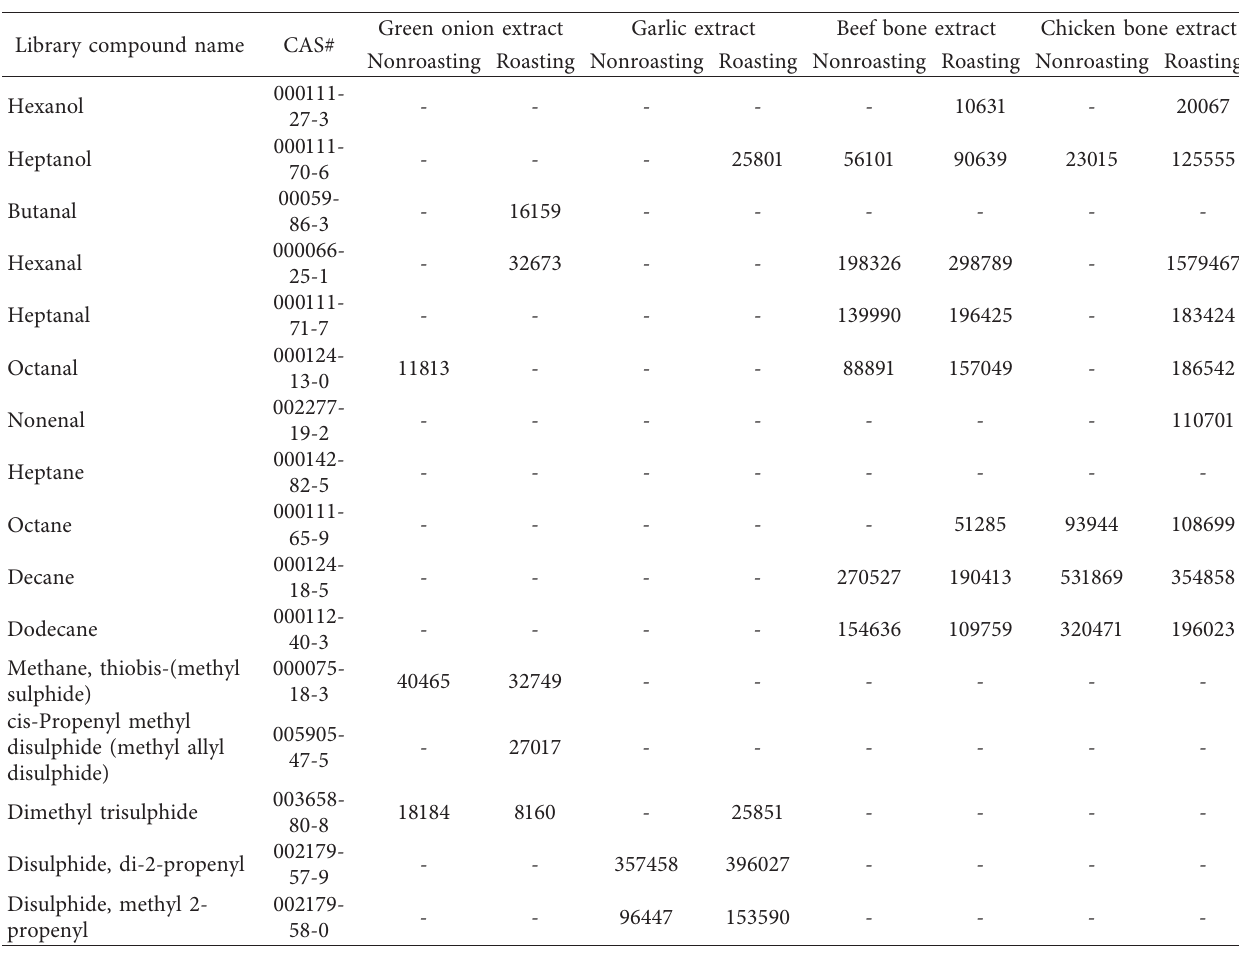
Table 2: Fragrance component composition by gas chromatography-mass spectrometry solid-phase microextraction analysis (GC-MS- SPME) (component name, CAS number, detection state, peak area).